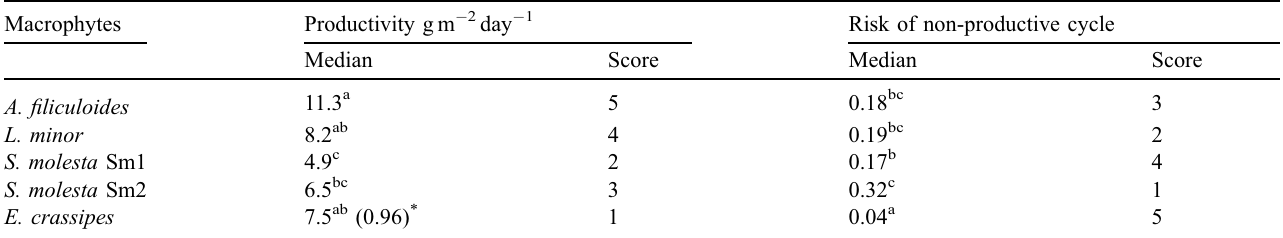
Table 2. Characteristics of productivity observed during the production cycles of aquatic macrophytes in tropical aquaculture ponds. Values in the same column with the same letter are not signi fi cantly different at P > 0.05 (Kruskal – Wallis ANOVA). * For E. crassipes , leaf biomass is given in parentheses.